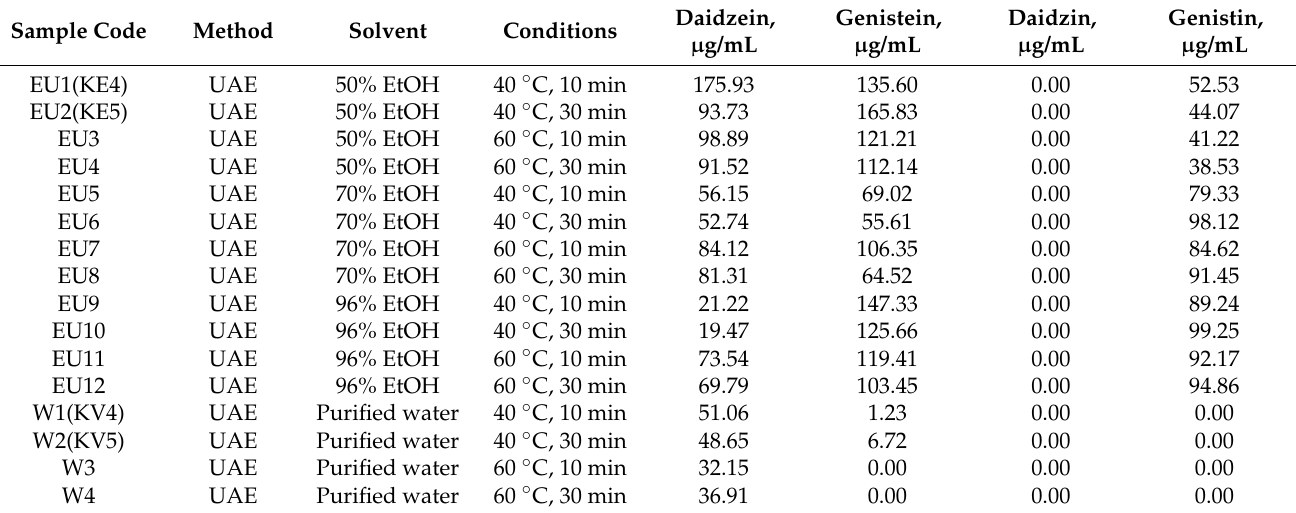
Table 4. Extraction conditions influence on yield of